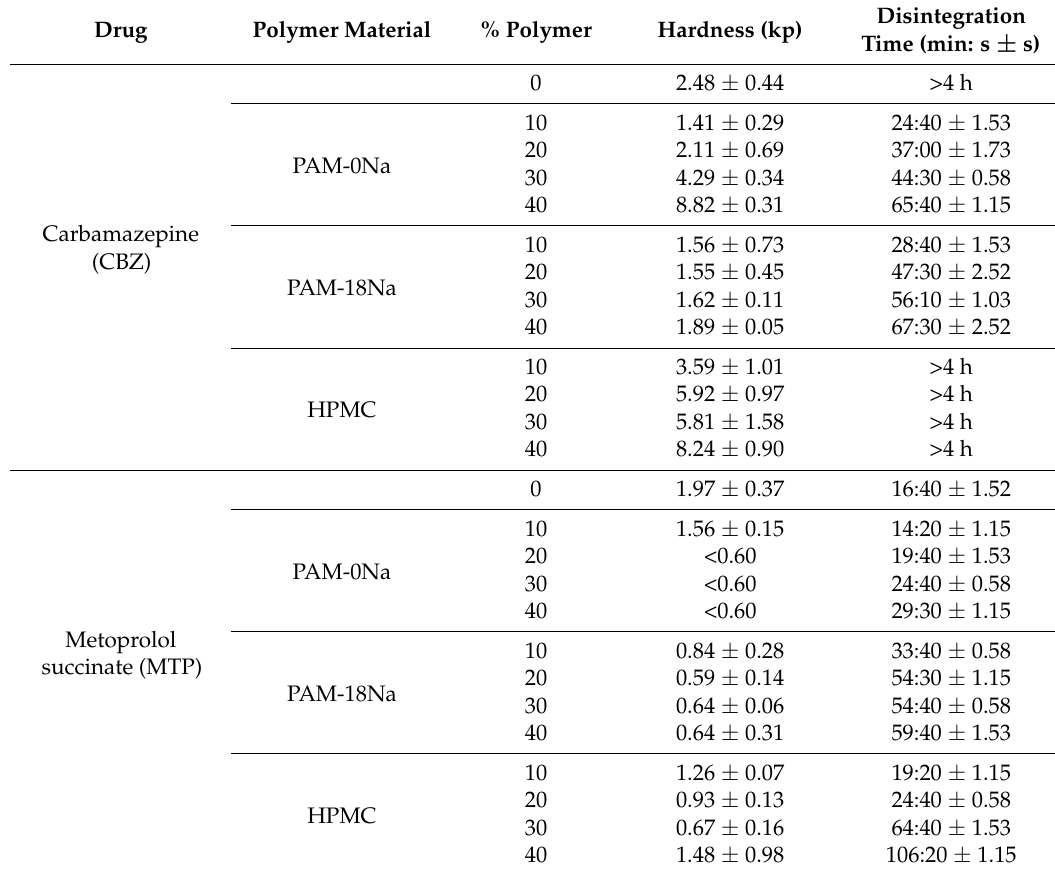
Table 2. Results of hardness and disintegration time for tablets elaborated with CBZ and MTP and different proportions of the PAM-0Na, PAM-18Na and HPMC